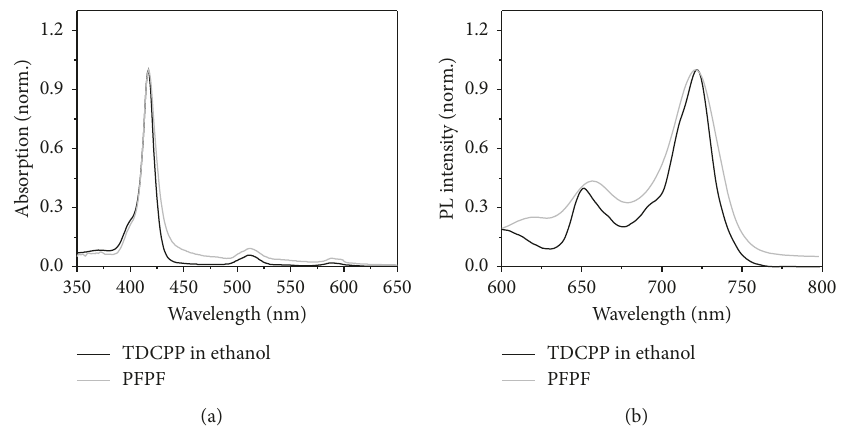
Figure 1: (a) Absorption and (b) emission spectra of TDCPP/ethanol and PFPF ( λ